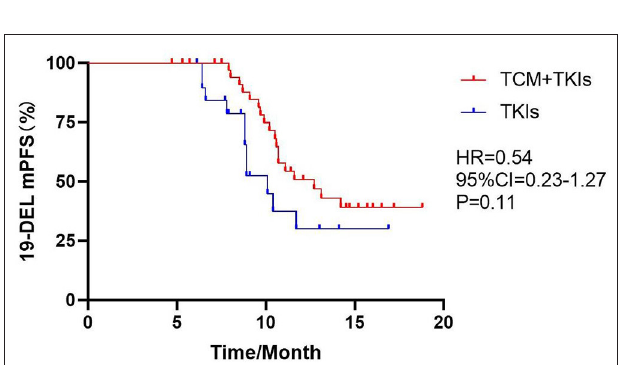
FIGURE 5 | Comparison of 19DEL mOS by two groups.